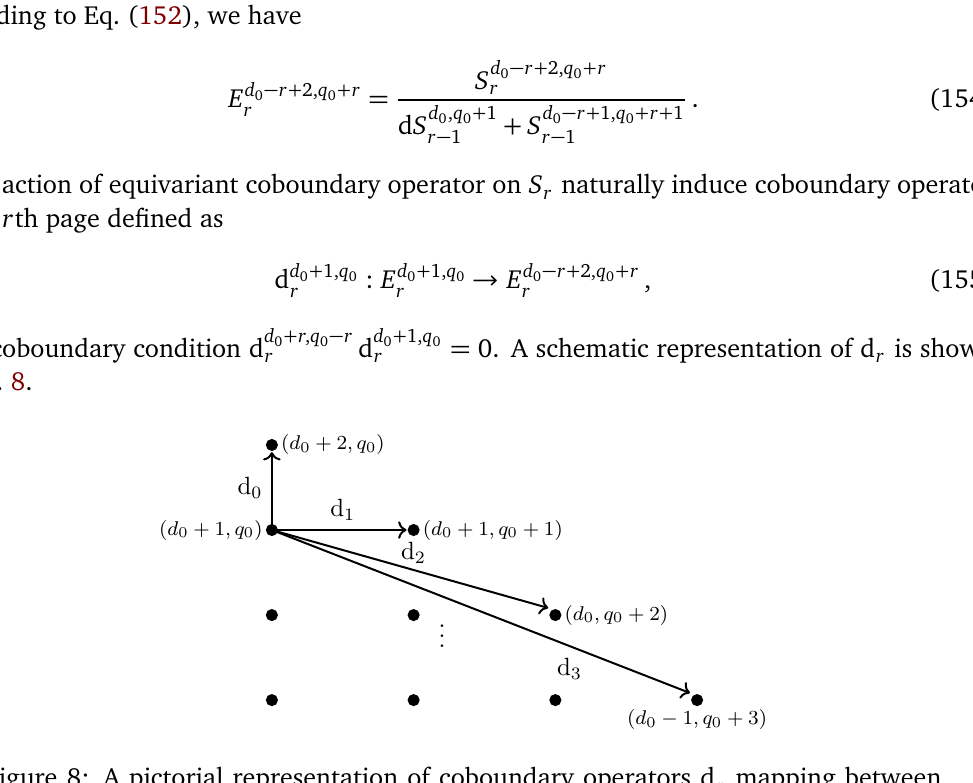
mapping between r